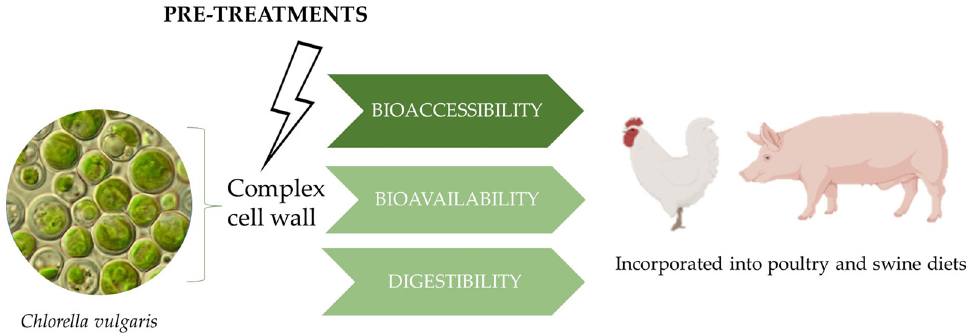
Figure 1. Bioaccessibility, bioavailability, and digestibility of Chlorella vulgaris fed to poultry and swine.